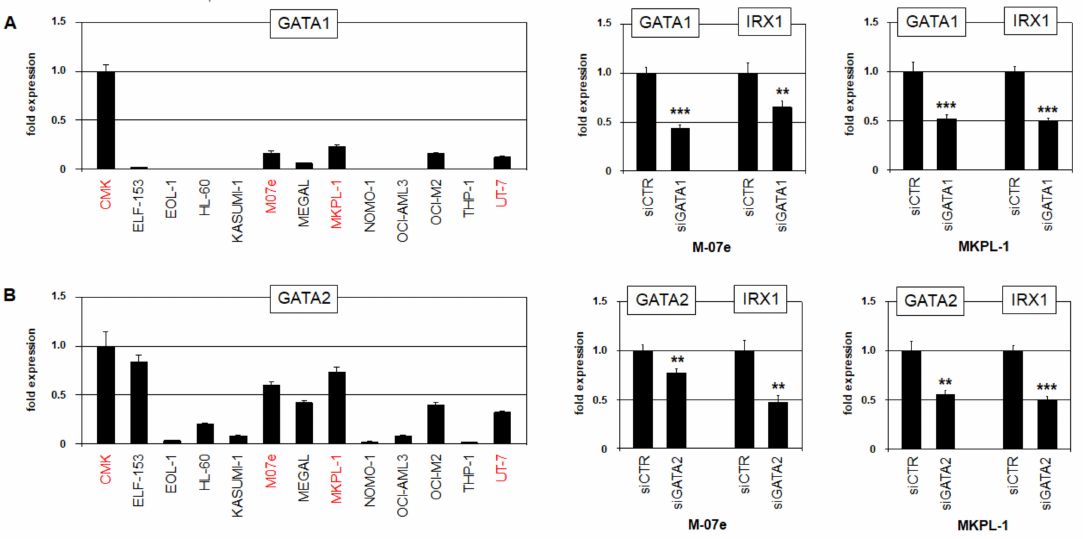
Figure 4. Transcriptional regulation of IRX1. Expression analysis of ( A ) GATA1 and ( B ) GATA2 by RQ-PCR in selected AML cell lines ( left ). Transcript levels are indicated in relation to CMK. Cell lines expressing significant levels of IRX1 are highlighted in red. SiRNA-mediated knockdown of ( A ) GATA1 and ( B ) GATA2 demonstrates activations of IRX1 and IRX5 in AML cell lines M-07e and MKPL-1 ( right ). p -values are indicated by asterisks (** p < 0.01, *** p <